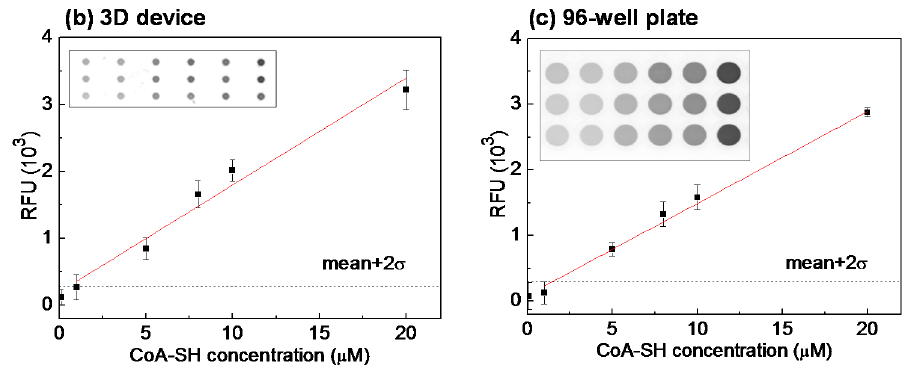
Figure 4. ( a ) Schematic illustration of HAT-based assay reaction. The Pf GCN5 enzyme catalyzes the acetylation and generates CoA–SH. The CoA–SH then reacts with the developer to produce signaling fluorophore; ( b , c ) the fluorescence intensity as a function of CoA–SH concentration on the 3D microfluidic device ( b ) and the 96-well microtiter plate ( c ). The insets show the scanning images corresponding to the plots in ( b , c ). The reaction volume in the 3D microfluidic device is 2 μ L, 50 times less than the 100 μ L in the 96-well microtiter plate. The red line is fitting for the linear range, which shows a good fit of R 2 = 0.93 and 0.98 for the 3D microfluidic device and the 96-well microtiter plate, respectively. The dashed line indicated the optical scanner’s limit of detection, which is determined as two standard deviations above the background from the negative control (buffer and HAT reaction mixture). Error bars correspond to three replicates.